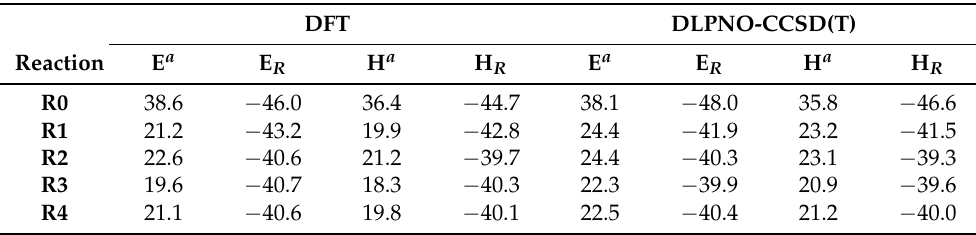
Table 2. Activation and reaction energy E a , E R and activation and reaction enthalpy H a , H R (kcal/mol) of reactions R0 – R4 investigated in this study. All energies/enthalpies are given relative to the last point on the IRC (van der Waals complex). B3LYP/6-31G(d,p)/SDD(Ti) and DLPNO-CCSD(T)/def2- TZVP levels of theory. DFT